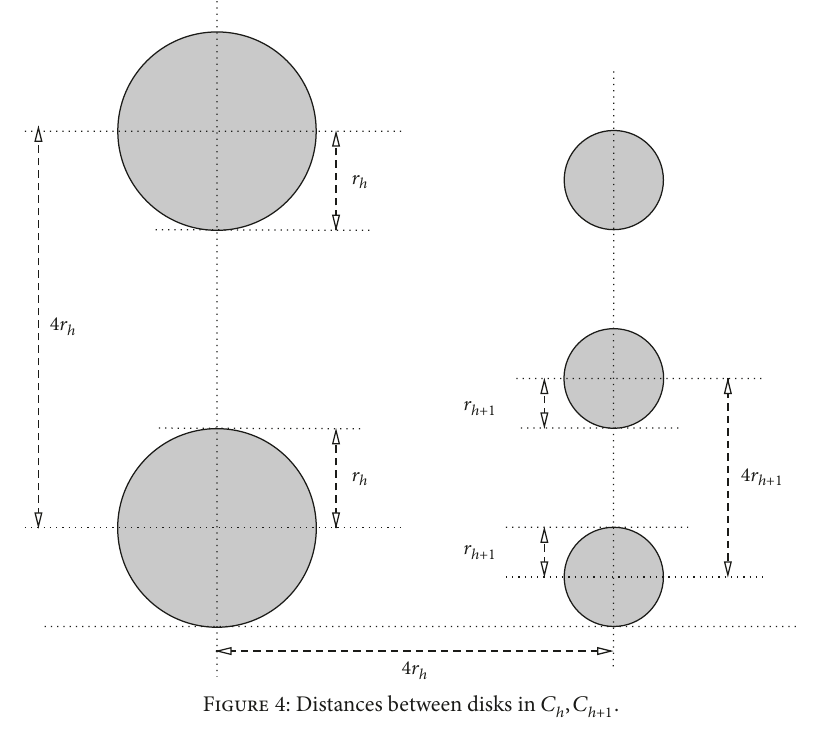
Figure 4: Distances between disks in 𝐶 ℎ ,𝐶 ℎ+1 .